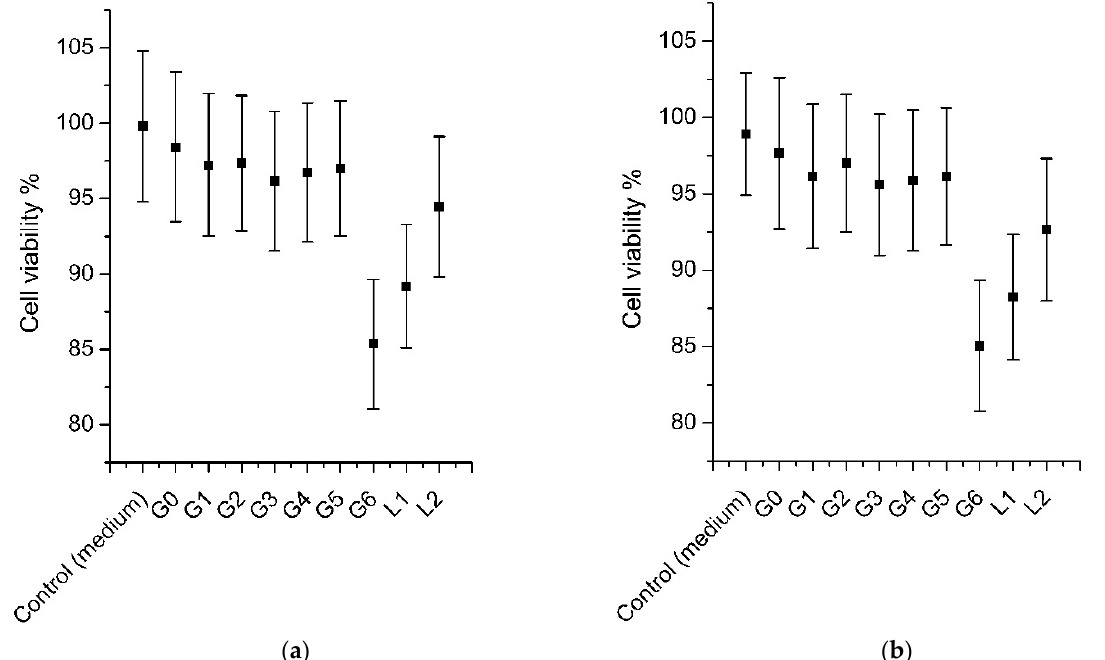
Figure 9. Percentage cell viability after the short time exposure (STE) test on the SIRC cell culture line (results expressed as the standard deviation of five measurements): ( a ) cell viability after 5 min; ( b ) cell viability after 30 min (mean ± SD, n = 3).